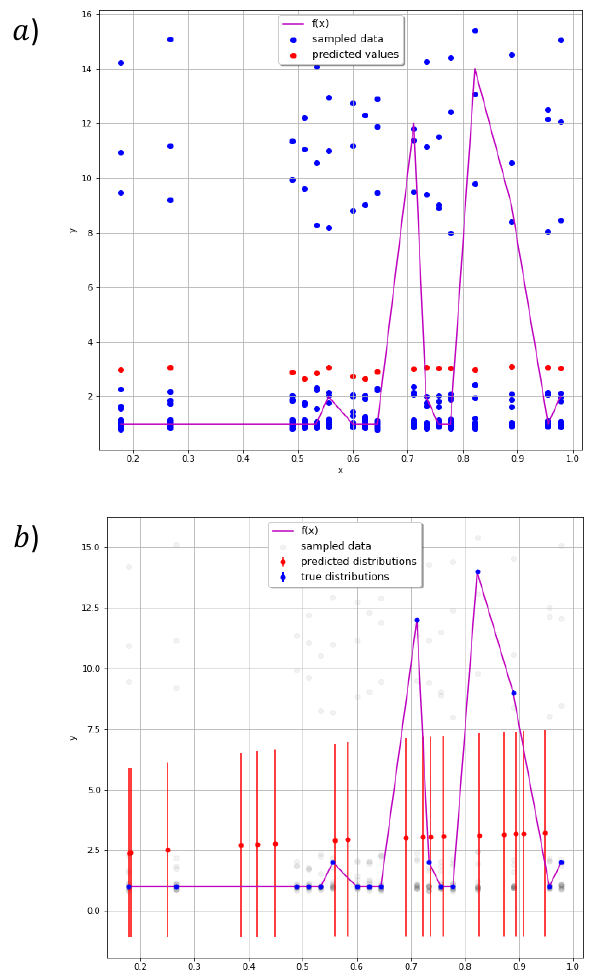
Figure 15. ( a ) Predicted frequencies for each random incompleteness ratio; ( b ) Predicted probability distribution for random incompleteness